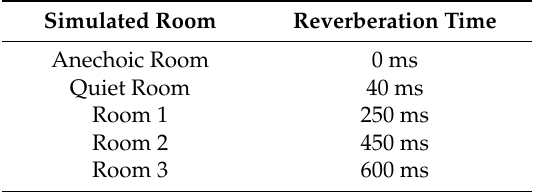
Table 3. Parameters of testing